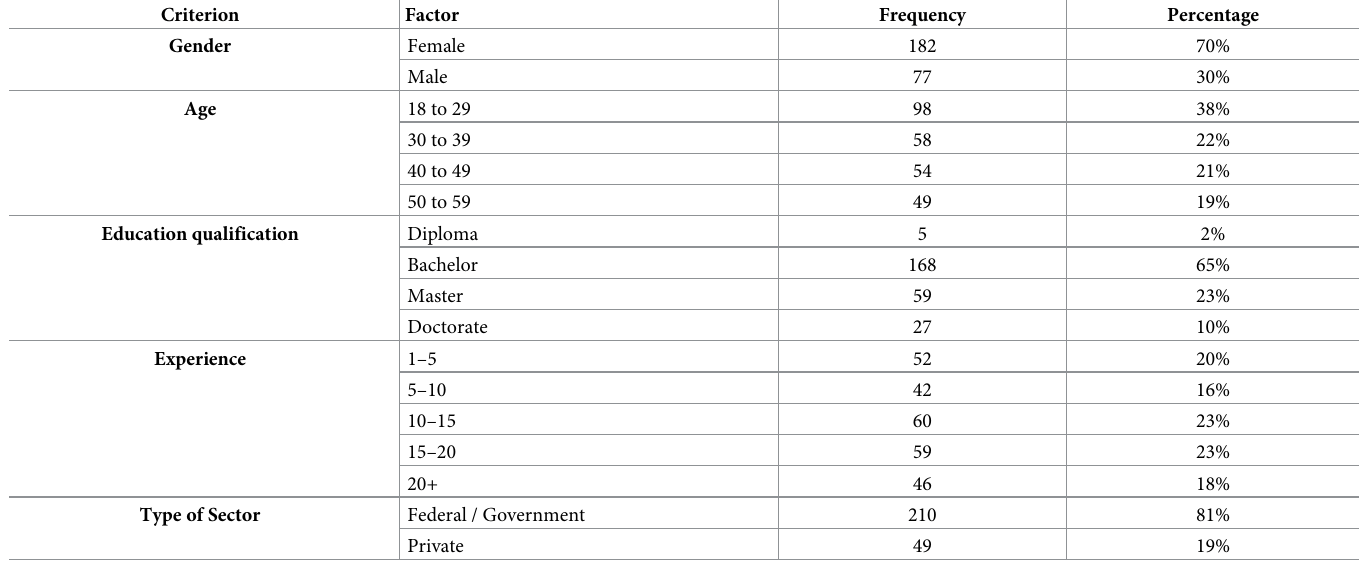
Table 1. Demographic information of participants.